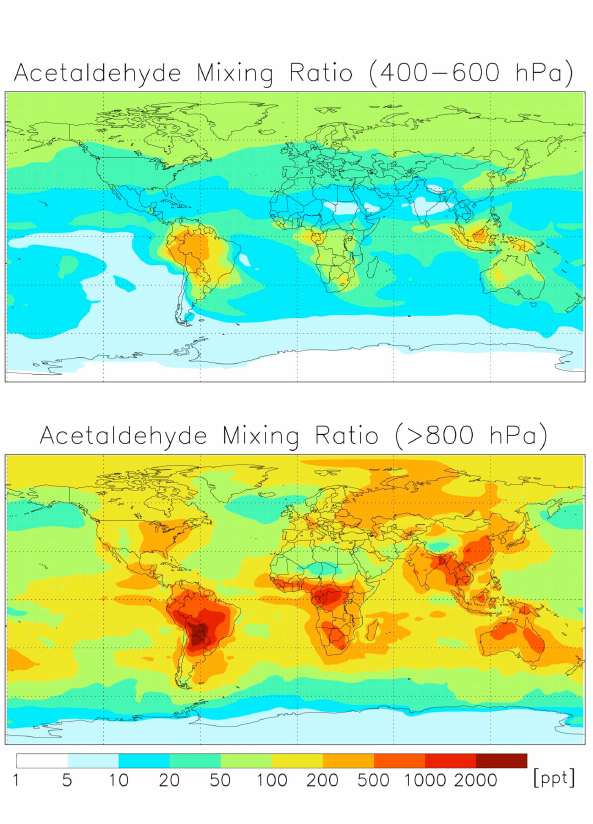
Fig. 7. Simulated global distribution of acetaldehyde mixing ratios (annual average) in the middle and lower